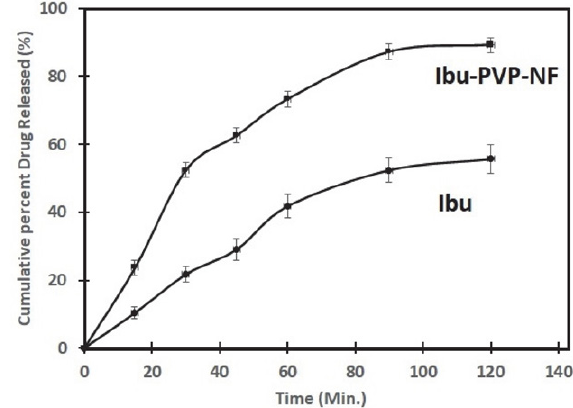
Fig 4. The dissolution profile of the raw ibuprofen (Ibu) and nano- fiber (Ibu-PVP-NF)